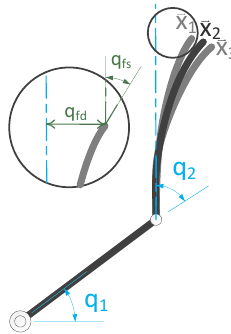
Figure 1. A flexible manipulator with the same configuration of rigid joints q r ( q 1 , q 2 ) but multiple end-effector position/orientation due to the flexibility of the links, q f ( q f flexural deflection and q f